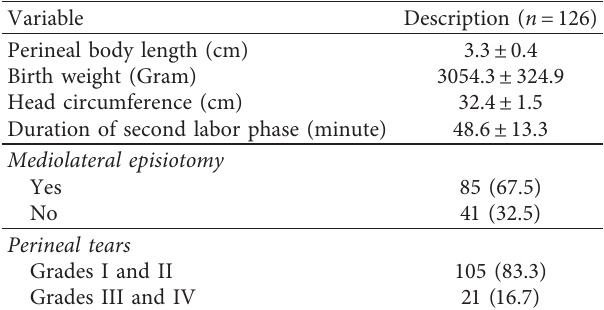
Table 1: Basic characteristics.